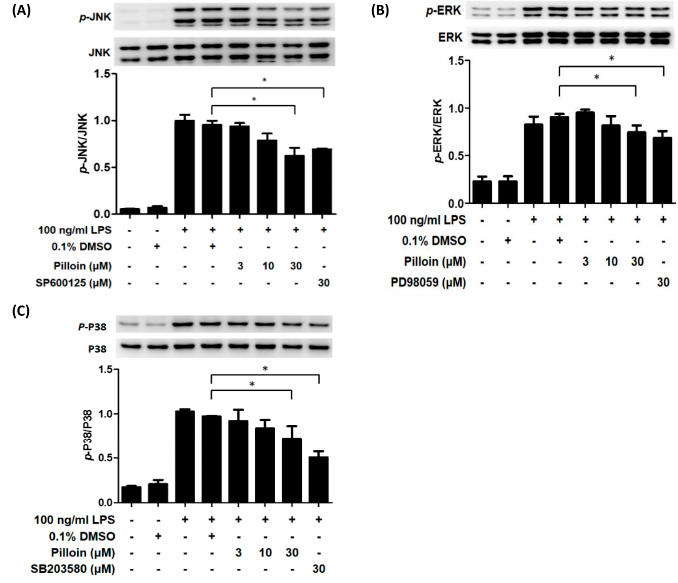
Figure 5. Effects of pilloin on MAPK signalling pathways in LPS-stimulated RAW 264.7 macrophages. RAW 264.7 cells (10 6 cells in MP-6 plates) were treated with vehicle, pilloin or the indicated inhibitor for 6 h before incubation with LPS (100 ng/mL) for 20 min. Cell lysates were analysed by Western blot to detect the activation of ( A ) JNK, ( B ) ERK and ( C ) p38. PD98059 (ERK inhibitor), SB203580 (p38 inhibitor) and SP600125 (JNK inhibitor) served as positive controls. * indicates a significant difference versus the LPS-treated group ( p < 0.05).